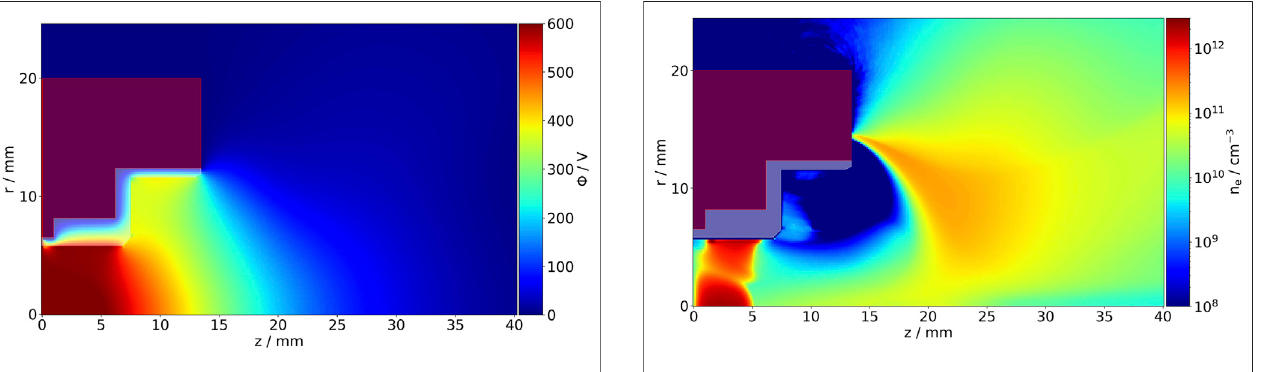
FIGURE 2 | Electrostatic potential Φ of the MS4. The metal casing (transparent red) and dielectric (transparent white) are also denoted.